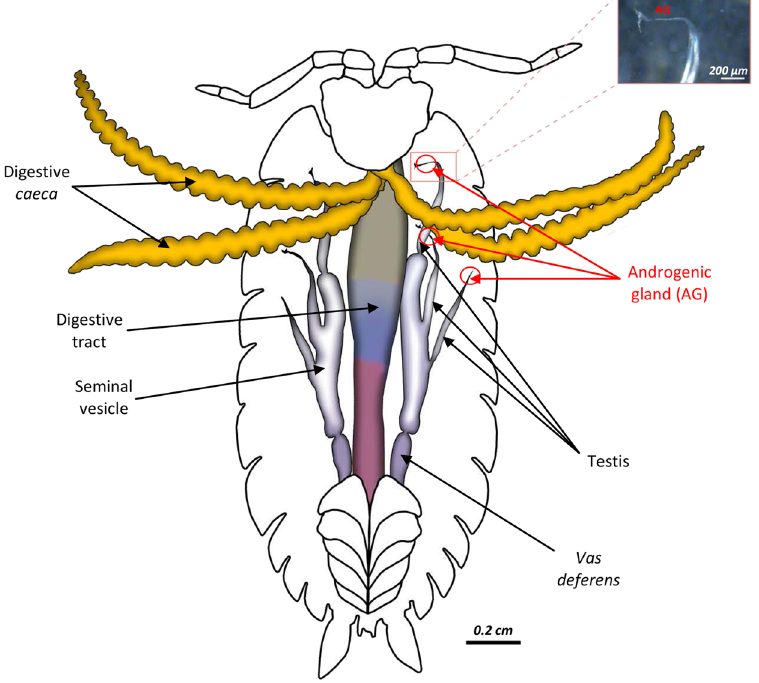
Figure 4. Schematics of the internal organs of a terrestrial isopod ( Oniscus asellus ) in ventral view. Androgenic glands, composed of a cellular mass excreting androgenic hormone, are located at the top of each testis, included in the suspensory filament. Depending on the species, its size is 250–700 µ m in length and 20–150 µ m in